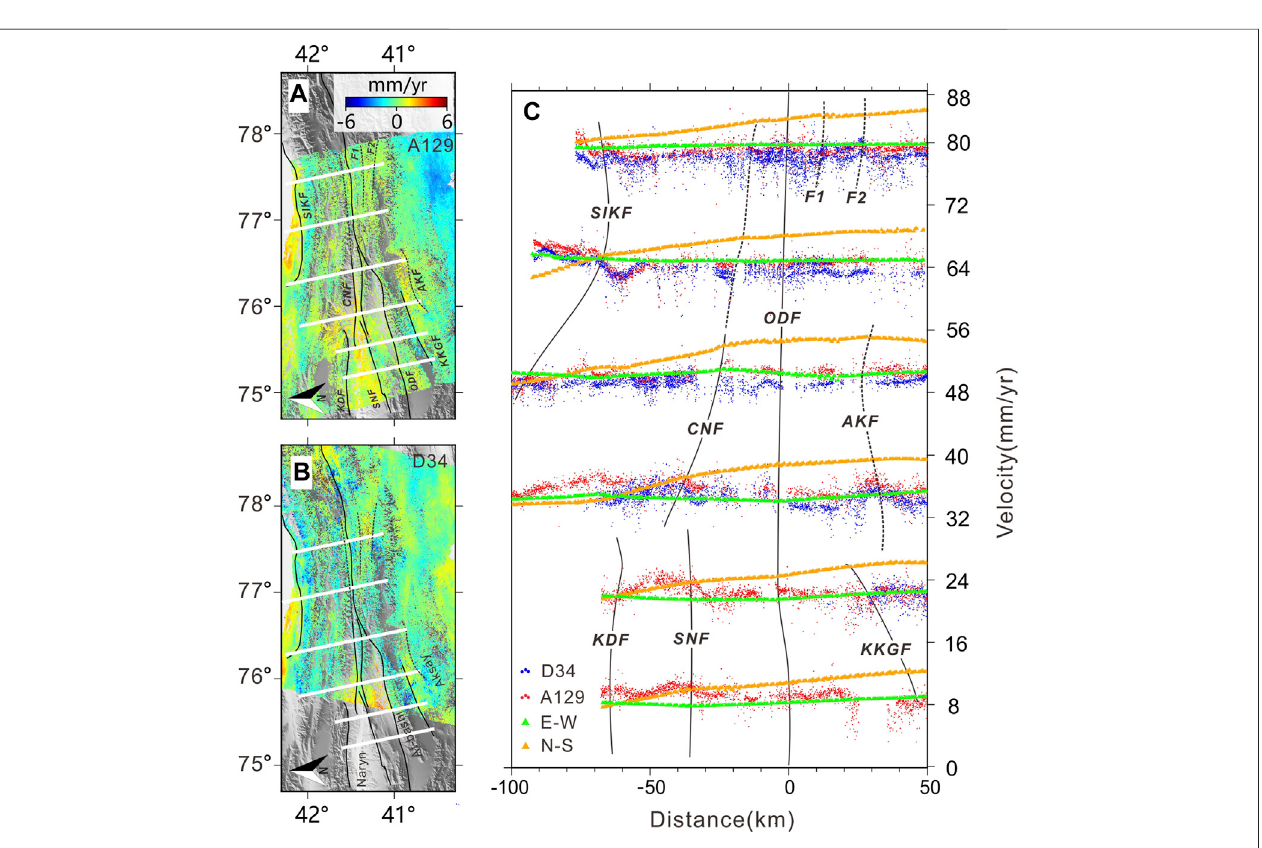
Frontiers in Earth Science |